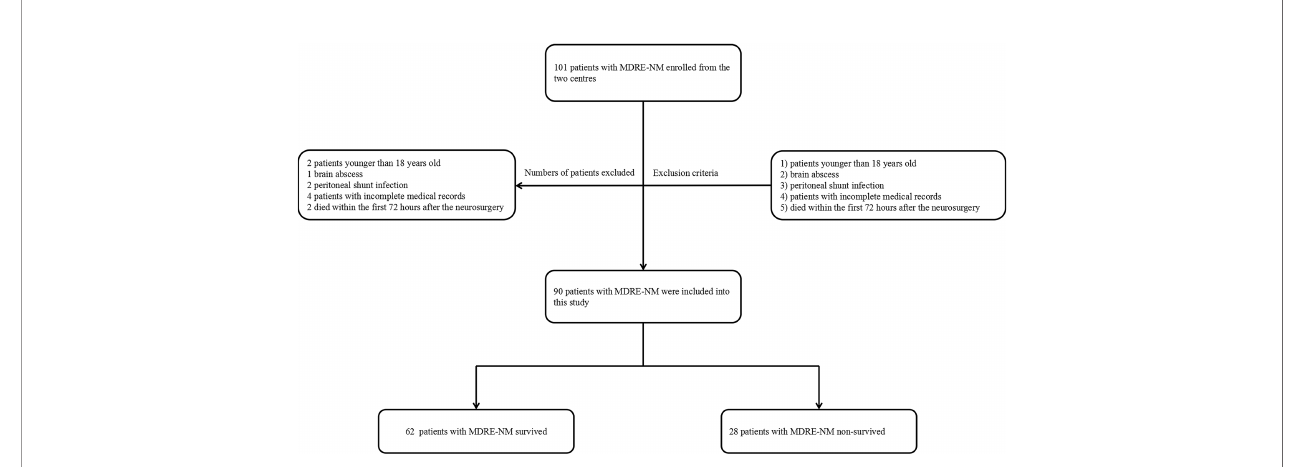
FIGURE 1 | Flowchart of patient inclusion. MDRE , multidrug-resistant Enterobacteriaceae; NM ,